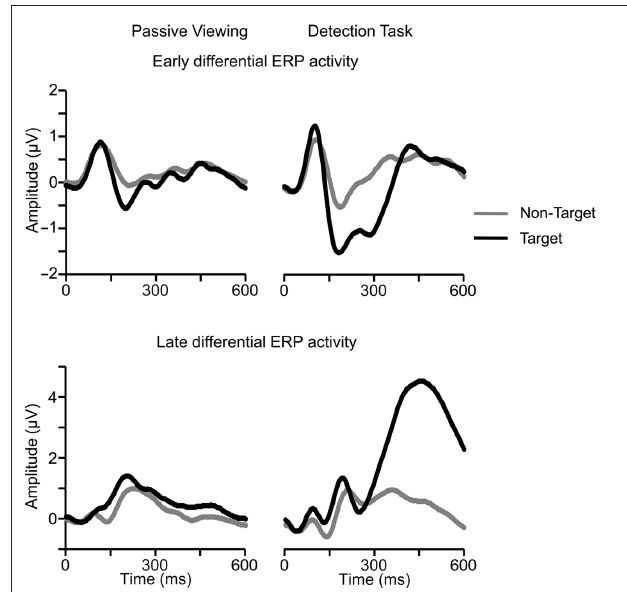
FiguRE 6 | illustration of the ERP waveforms to non-target and target stimuli in the active and passive task condition for early (#166) and late (#129) differential ERP activity associated with target stimulus